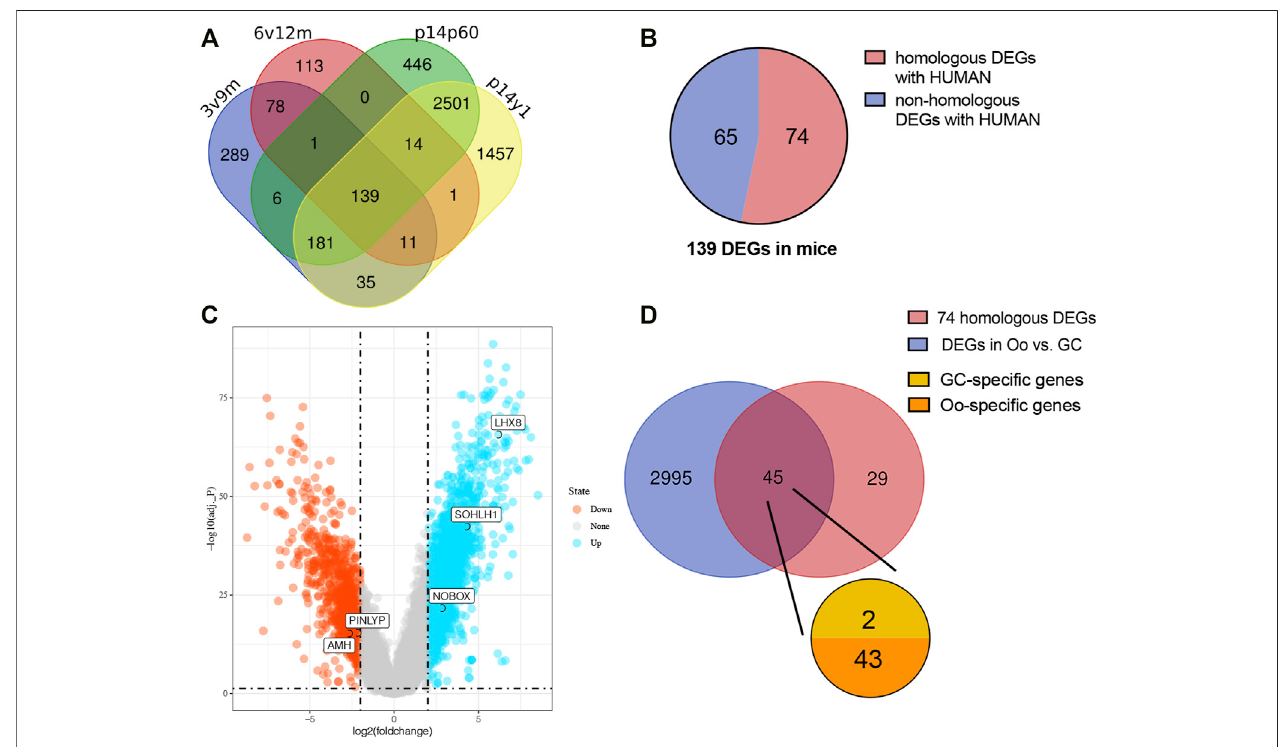
FIGURE 3 | Screening the intersected upregulate DEGs related to human oocyte (A) Venn diagram demonstrates the overlap of the murine upregulated DEGs in fourhighervs.lowerORgroupsofBOAcomparison. (B) Thepiechartrepresentsthe139intersectedupregulatedDEGshomologouswithhumans(red)ornot(blue). (C) Volcano plots for DEGs of human oocytes (Oo) and granulosa cells (GC) from dataset GSE107746. The blue points represent the upregulated genes in Oo, and the red pointsrepresenttheupregulatedgenesinGC.DEGswerescreenedonthecriterionoflog2|FC| > 2.0andadj. p < 0.05. (D) Venndiagramof74upregulatedmurine the homologous DEGs and the DEGs in human Oo and GC (blue) demonstrates the overlap of the upregulated murine DEGs related to human Oo- (orange) or GC- speci fi c (yellow)